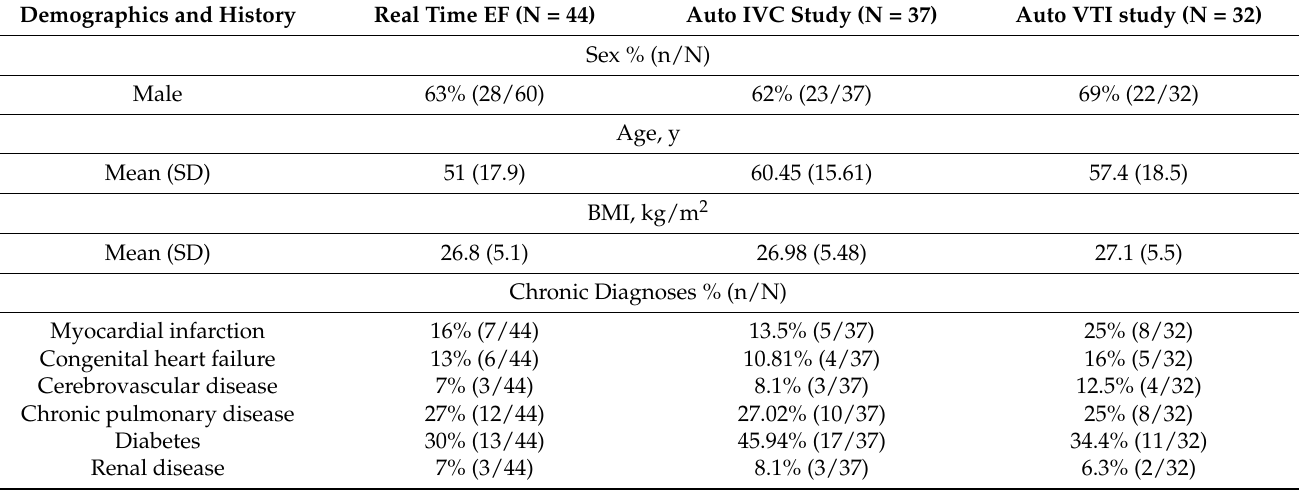
Table 1. Characteristics of patients.